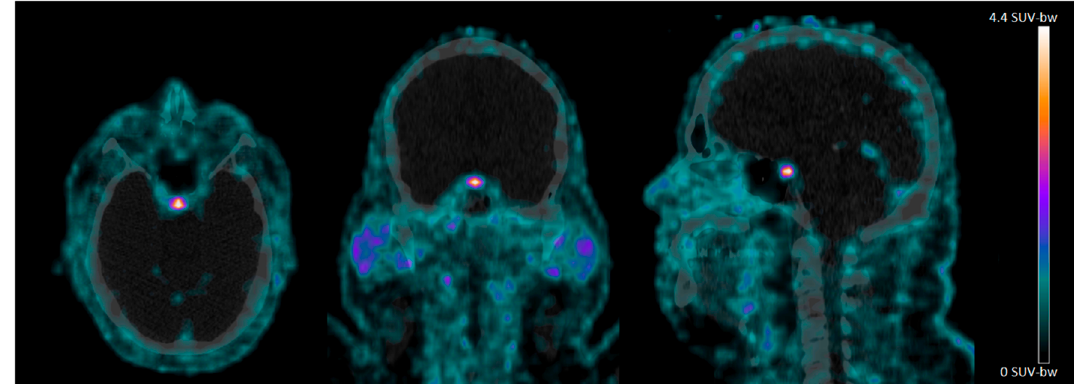
Figure 1. 68 Ga-NODAGA-exendin-4 PET/CT scans of the head acquired 60 min after injection in an obese subject. Note the intense uptake in the pituitary. Table 2. Uptake values of 68 Ga-NODAGA-exendin-4 ( n = 10).